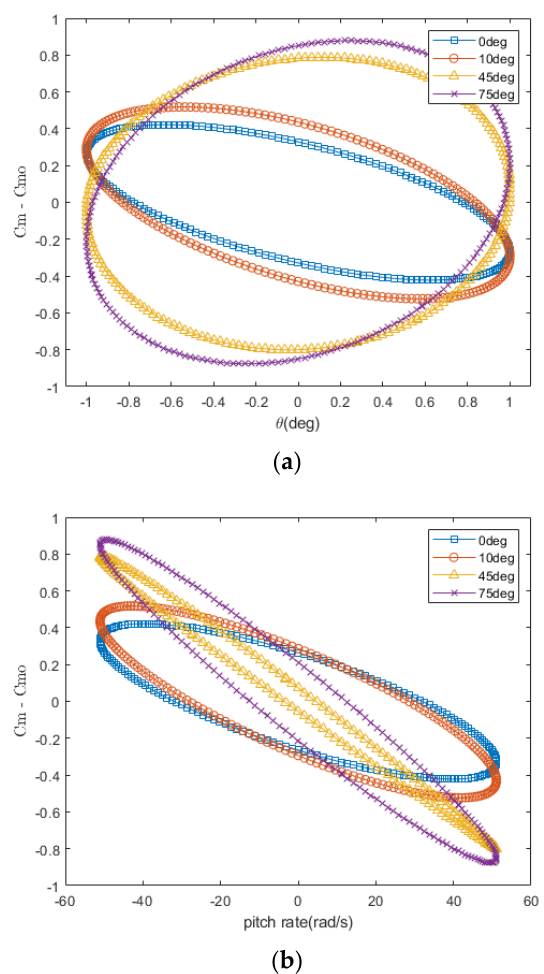
Figure 13. History plot for ( a ) 𝐶 (cid:3040) (cid:3398) 𝐶 (cid:3040)